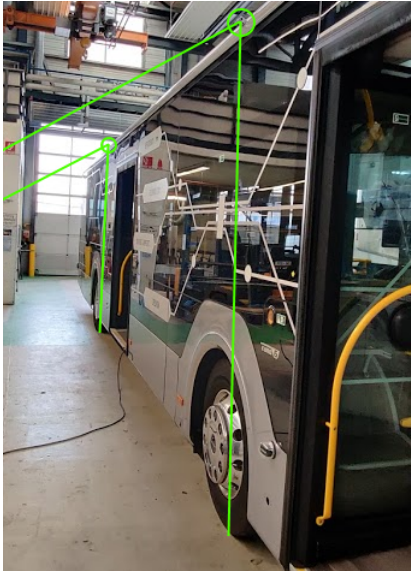
Figure 1. Mounting of top-view cameras on a city bus - exemplary field of view is given by the green lines perpendicular to the busses outer